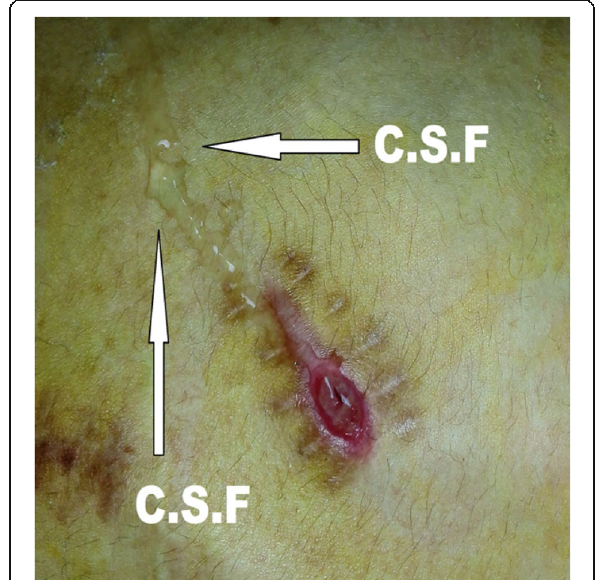
Fig. 6 Photograph of a 16-year-old male patient showing CSF leak (white arrows) through ulceration of the skin over the distal catheter of left VP shunt at the